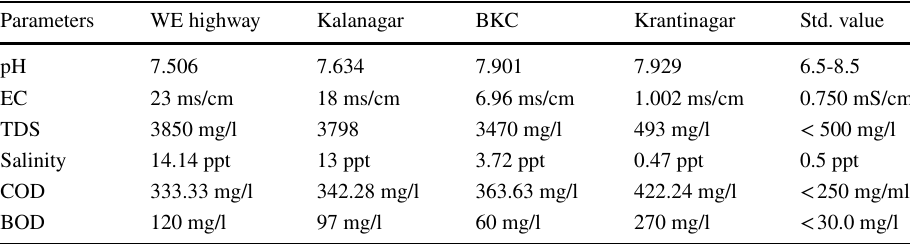
Table 1 Physicochemical analysis of the water samples collected along four sites of the Mithi river